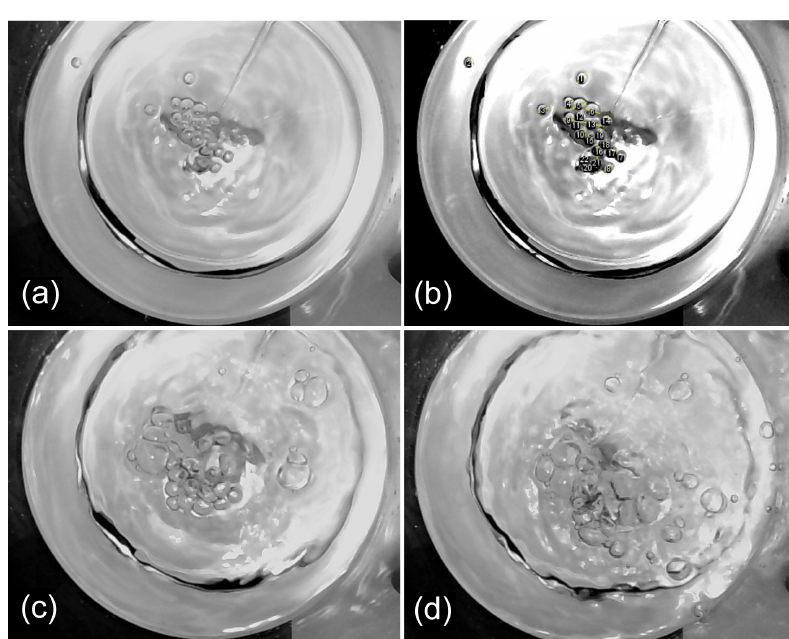
Figure C1. One of five images taken at 0.2, 0.8, and 1.5Lmin − 1 flow rates and S = 0.1M water salinity from above the bubbling area. (a) The initial picture at 0.2Lmin − 1 . (b) Modified image at 0.2Lmin − 1 , with the bubble diameters selected and numbered. (c) The initial picture at 0.8Lmin − 1 . (d) The initial picture at 1.5Lmin − 1 .